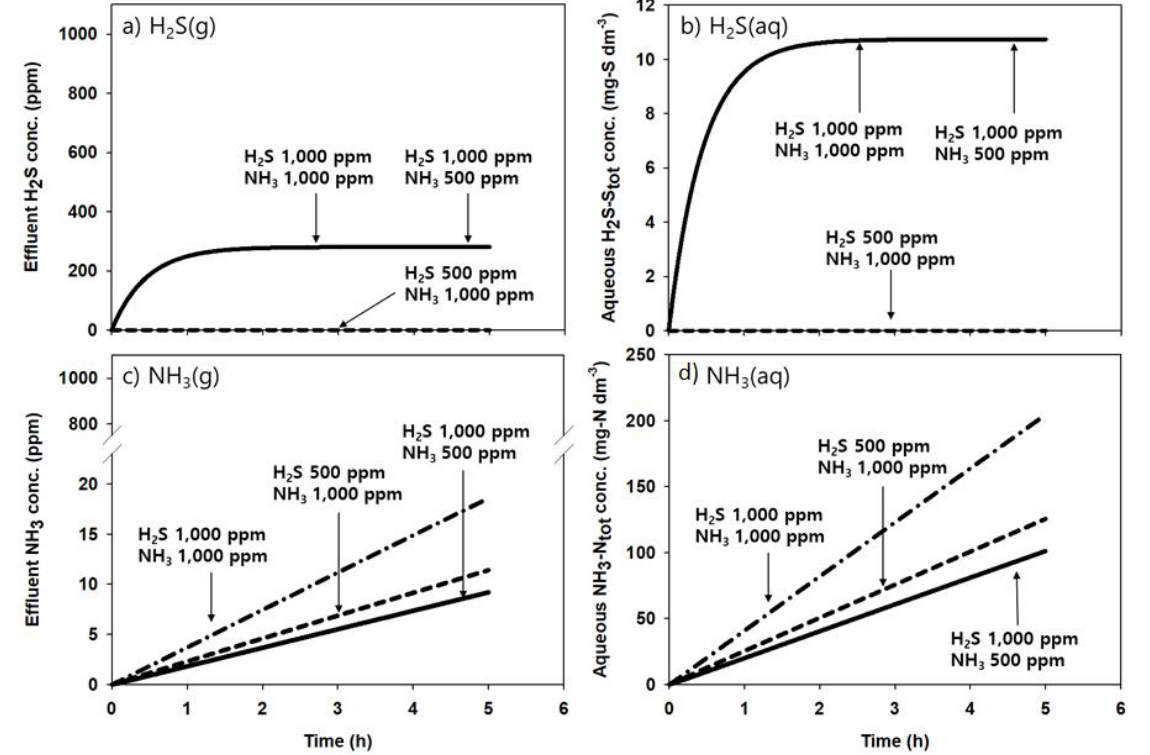
Figure 4. Simulated results of EWS at different inflow concentrations of H 2 S and NH 3 for 6 h: ( a ) effluent H 2 S concentration (ppm), ( b ) aqueous H 2 S concentration in solution (mg-S dm − 3 ), ( c ) effluent NH 3 concentration (ppm), ( d ) aqueous NH 3 concentration in solution (mg-N dm − 3 ) as a function of time.